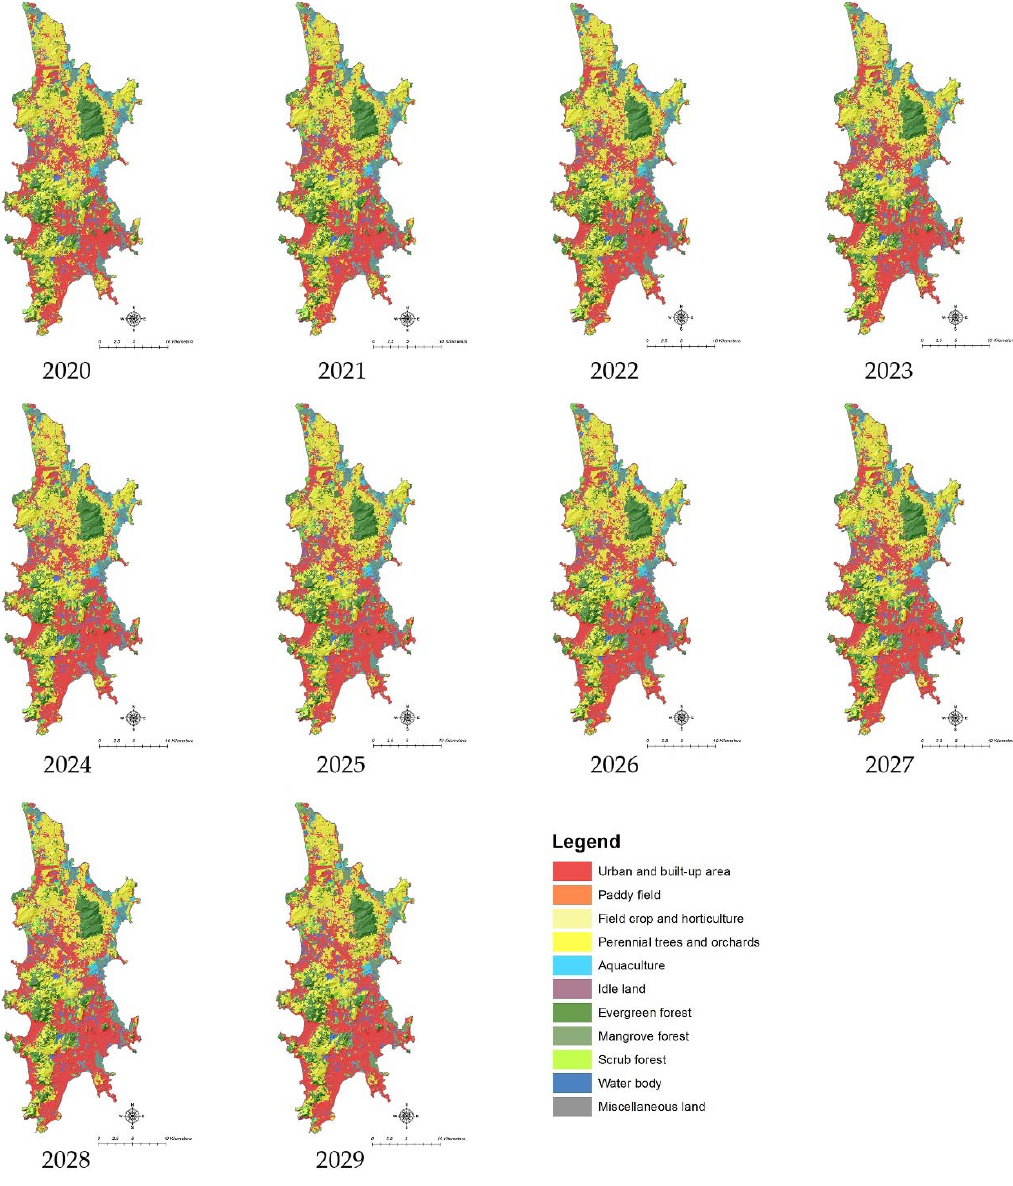
Figure 7. Spatial distribution of the simulated LULC scenario between 2020 and 2029. According to the results, the LULC types that will increase in 2029 are urban and built-up areas, field crops and horticulture, idle land, scrub forest, and water bodies. On the contrary, the LULC types that will decrease in 2029 are paddy fields, perennial trees and orchards, aquaculture, evergreen forest, mangrove forest, and miscellaneous land. These findings are based on the driving factors of LULC change, conversion matrix, and elasticity of LULC change and their land requirements, which were applied to the CLUE-S model for LULC simulation between 2020 and 2029. In this study, a slight difference was found between the land demand (required land area) and the simulated area of each LULC type in 2029. The deviation between the land demand and the simulated area in 2029 is − 0.01 km 2 because the deviation value depends on the iteration driving factors of each LULC type, which indicates the different maximum allowances between the required and allocated areas of LULC types under the CLUE-S model